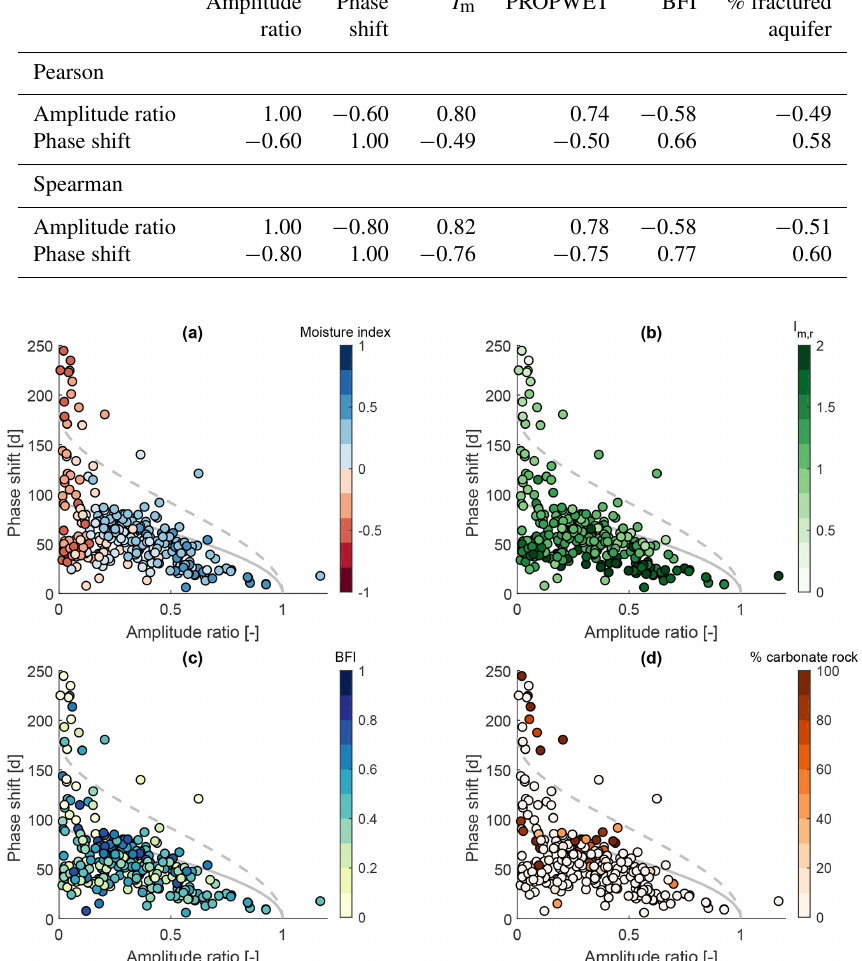
Figure 7. Amplitude ratio against phase shift for CAMELS catchments. Catchments with a snow fraction ( f s > 0 . 001) are removed from the analysis. The grey solid line indicates a single linear reservoir, and the grey dashed line indicates the outer envelope for two reservoirs in parallel. Colours indicate (a) the moisture index, (b) the moisture index seasonality, (c) the baseflow index, and (d) the fraction of carbonate sedimentary rock. Note that both axes are limited (12 catchments are not shown) and that the range of the phase shift axis is different from Fig.